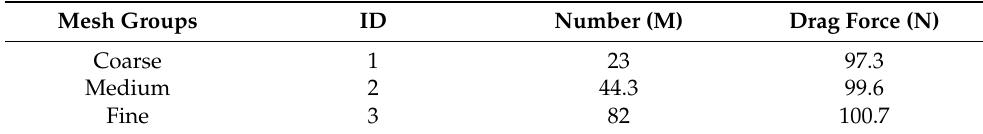
Table 1. The calculation results of the total drag